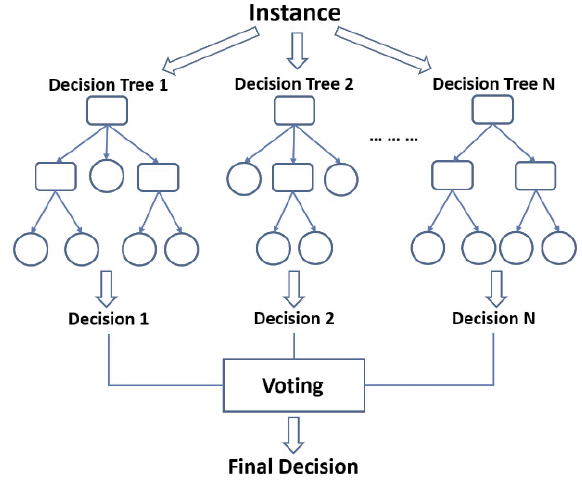
Figure 10. An illustration of the RF Algorithm [25].